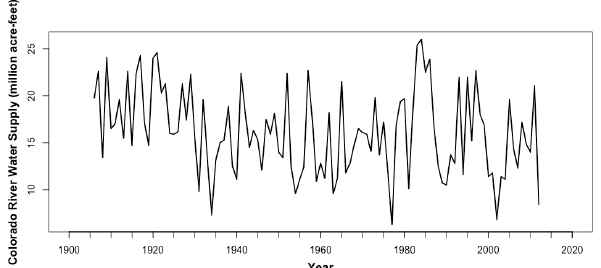
Figure 1. The annual basin-wide water supply (WS) data of the Colorado River from 1906 to 2012. To get a first impression of the correlation structure of 𝑋 (cid:3047) , the autocorrelation function (ACF) and the partial autocorrelation function (PACF) of 𝑋 𝑡 were computed (Figure 2). There appear to be a few significant lags, in the ACF at lag 1 and in the PACF at lags 1 and 2. The correlations at lags 13 and 19 are marginally significant in the ACF, and so is the correlation at lag 12 in the PACF. These significant lags suggest that an autocorrelation structure in the WS data is present, one that can be utilized to build univariate time series models, such as the autoregressive moving-average (ARMA) (p, q), for predicting WS based on its own historical observations. Here, the numbers p and q denote the autoregressive and moving-average orders, respectively. Readers are referred to, e.g., (Brockwell et al. 2002) [14] for the mathematical details. Figure 2. ( a ) The autocorrelation function (ACF) and ( b ) partial autocorrelation function (PACF) of the first-order difference of the Colorado River WS time series. The two blue dashed lines on each plot denote the corresponding 95% confidence interval.